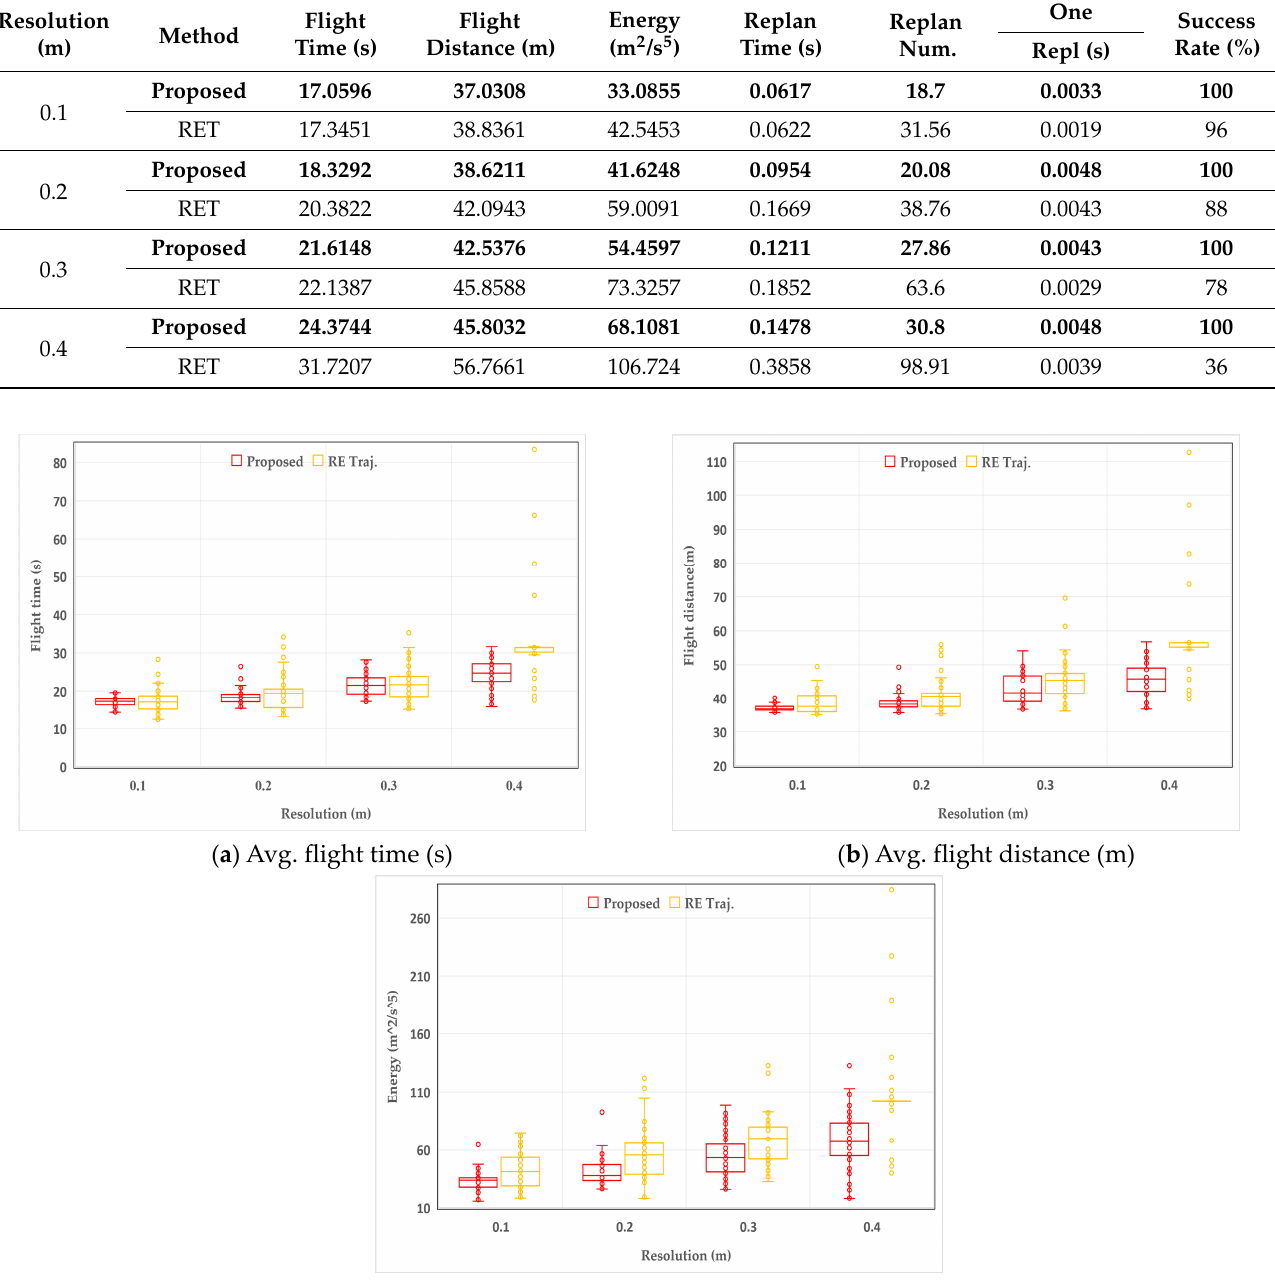
Figure 12. Results distribution of the comparisons between the proposed method and RET in different resolutions.